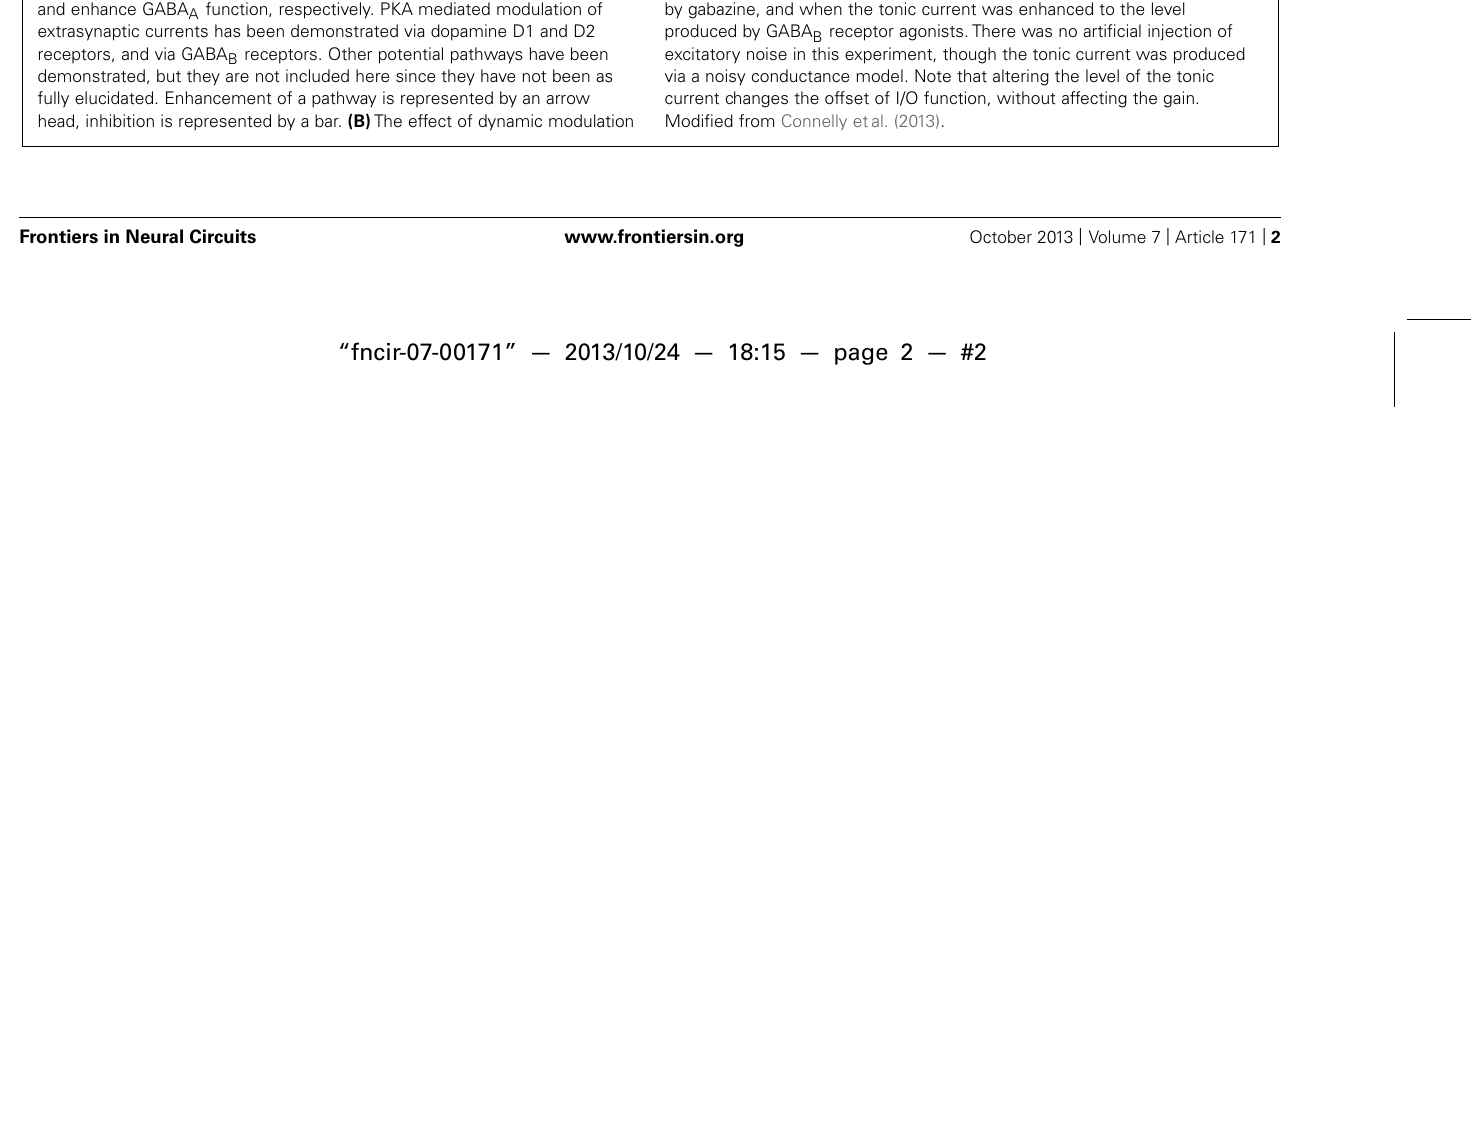
FIGURE 1 | Modulation of extrasynaptic GABA A receptors. (A) PKC leads to phosphorylation of α 4 and β 3 subunits, which increases cell surface stability. PKA leads to phosphorylation of β 1 and β 3 subunits, which inhibit and enhance GABA A function, respectively. PKA mediated modulation of extrasynaptic currents has been demonstrated via dopamine D1 and D2 receptors, and via GABA B receptors. Other potential pathways have been demonstrated, but they are not included here since they have not been as fully elucidated. Enhancement of a pathway is represented by an arrow head, inhibition is represented by a bar. (B) The effect of dynamic modulation